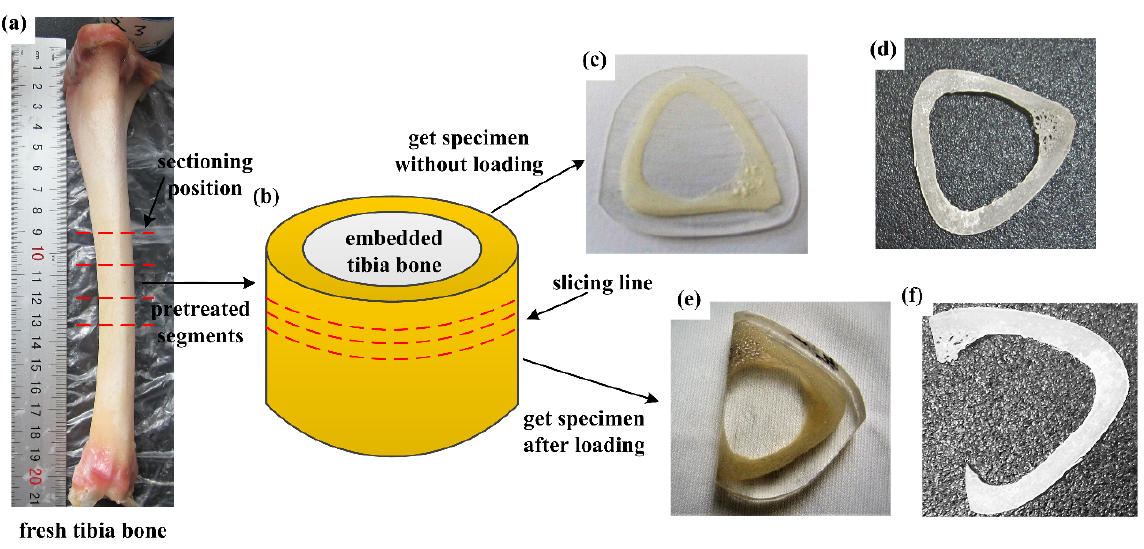
Figure 1: Specimens preparation and pre-treatment. ( a ) Fresh goat tibia; ( b ) 1-2 cm cortical bone segment after embedding; ( c ) 1-2 mm thin specimen transversely sliced from the embedded segment; ( d ) specimen without loading treated by degumming; ( e ) embedded segment after two steps of polishing; ( f ) specimen after loading treated by